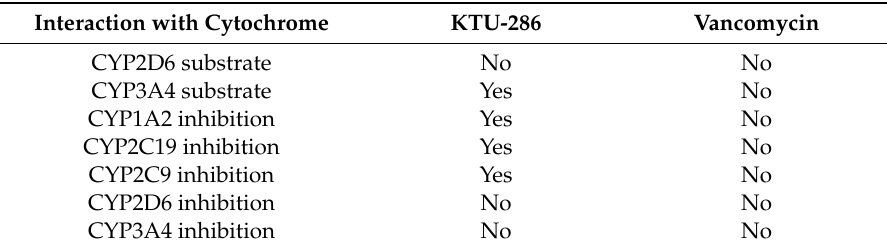
Table 3. The in silico pharmacological prediction of KTU-286 interaction with major human-cytochrome- mediated metabolism systems was estimated using pkCSM